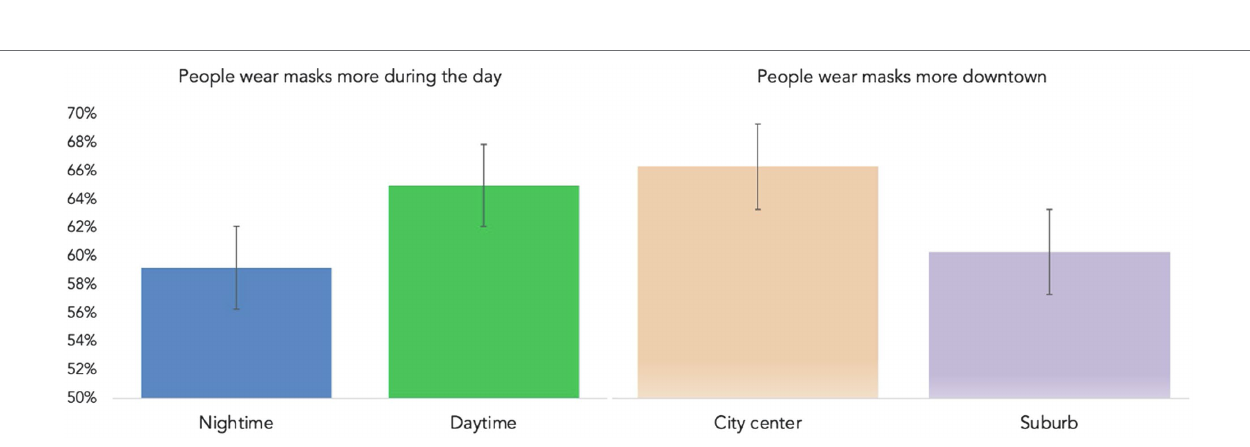
FIGURE 1 | Map of Shanghai’s 16 districts with lables of total COVID-19 ( n ) cases in each district we conducted the mask observation (left) . Overall, 59.8% males wore masks while 66.2% female wore masks (right) . Error bars represent ISD.